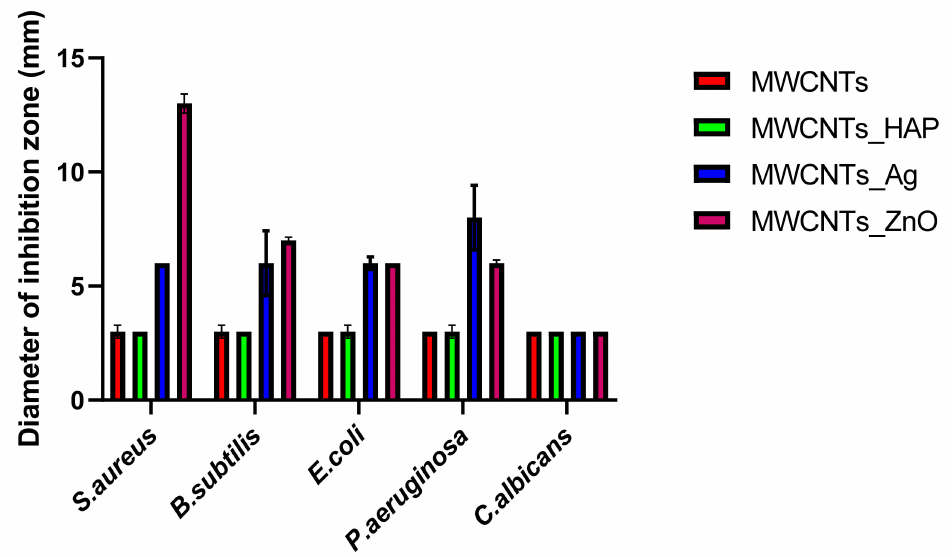
Figure 10. Graphical representation of the diameter of the growth inhibition zone of the microbial strains tested for MWCNTs and decorated MWCNTs. Data represented were mean of triplicate values with standard